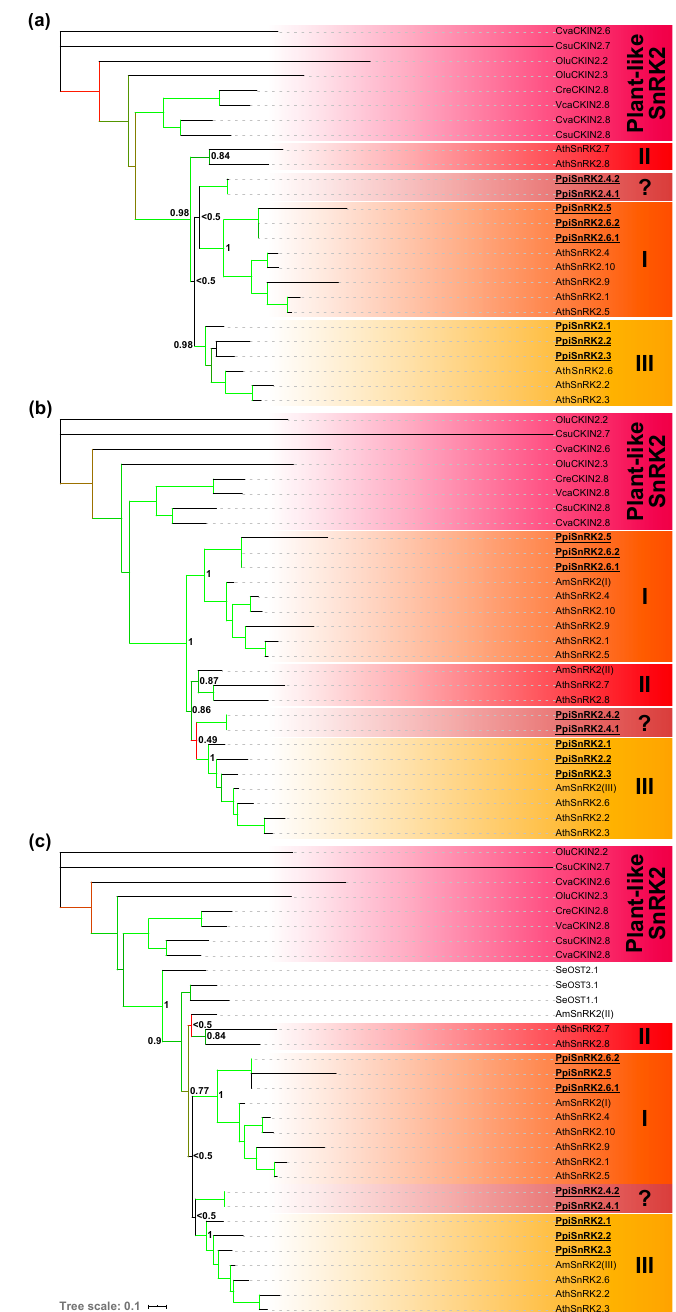
Figure 2. Rooted SnRK2 ML trees including SnRK2 orthologs from different sets of species along Pinus pinaster PpiSnRK2s: ( a ) P. pinaster (PpiSnRK2) and Arabidopsis thaliana (AthSnRK2) SnRK2 sequences along the plant-like SnRK2 orthologs (CKIN2) of different microalgae species including Chlamydomonas reinhardtii (CreCKIN2), Volvox carteri (VcaCKIN2), Dunaliella salina (DsaCKIN2), Chlorella variabilis (CvaCKIN2), Coccomyxa subellipsoidea (CsuCKIN2) and Ostreococcus lucimarinus (OluCKIN2); ( b ) same species and sequence set including Amborella trichopoda (AmSnRK2) SnRK2 orthologs and ( c ) same previous species and sequence set including A. trichopoda (AmSnRK2) and Selaginella moellendorfii (SeOST) SnRK2 orthologs. Selaginella and Amborella SnRK2 sequences, plant species with simpler SnRK2 subfamilies, were added to this SnRK2 sequence trees to evaluate the orthology links between the P. pinaster and these species SnRK2 subfamilies and their possible use as models for the characterization of the gymnosperm PpiSnRK2. Tree branches were colored according to their FBP bootstrap value, thus, branches with FBP values below 0.5 are black while these above 0.5 FBP are colored from red (0.5) to light green